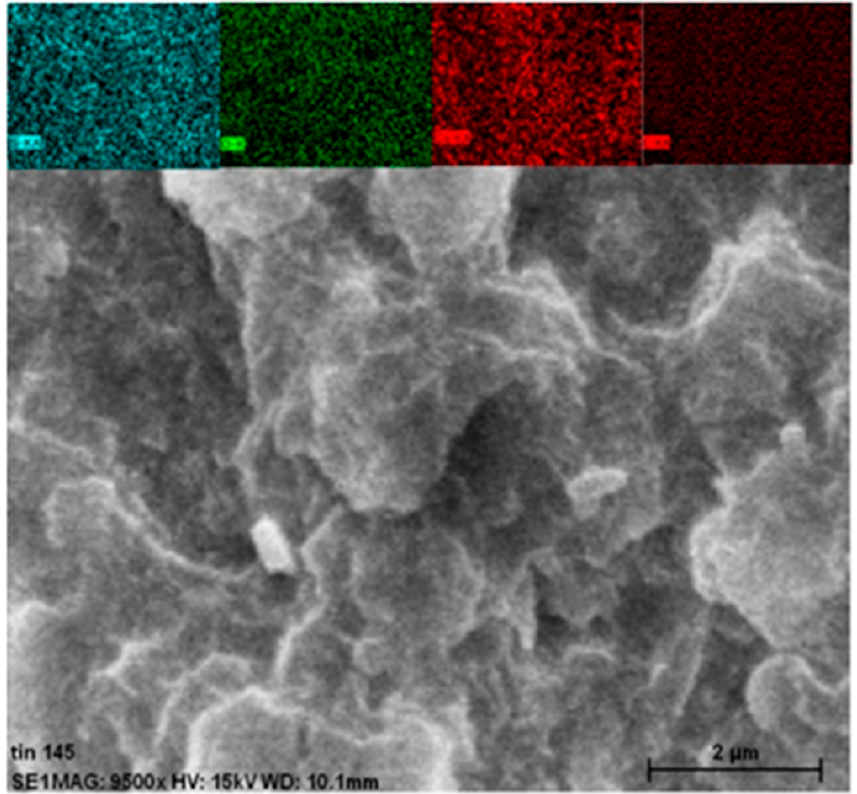
Figure 6. Scanning electron micrograph (SEM) of PEDOT/nano Co 3 O 4 /rGO (main image). Inset images at the top depict EDX of S, O, Co, and C, respectively, from left to right. An XPS analysis of the PEDOT/nano Co 3 O 4/ rGO nanocomposite is provided in Figure S3. Peaks attributable to S 2p, O 1s, C 1s, Co 2p, and O 1s, respectively, were identified. The O 1s and C 1s spectra derive from PEDOT and rGO, while the S 2s is derived from the PEDOT